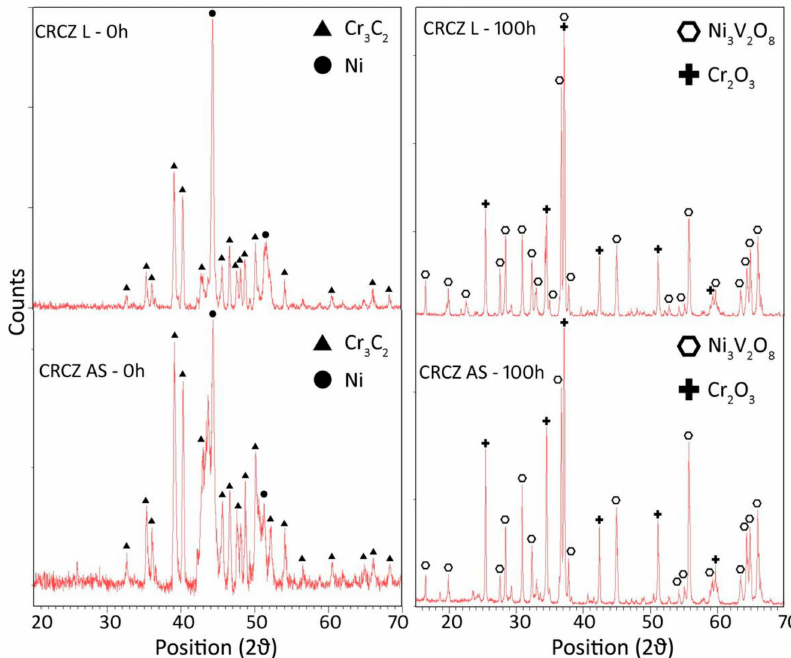
Figure 8. XRD patterns for the CRCZ samples: AS—as sprayed (lower left); L—laser treated (upper left); AS-100 h—as sprayed, exposed for 100 h (lower right); and L-100h—laser treated, exposed for 100 h (upper